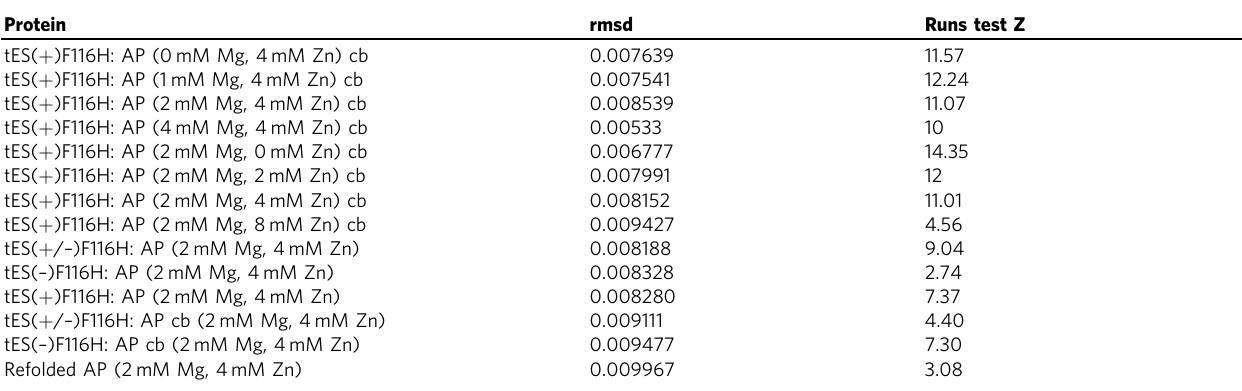
Determining the quality of fi t for AUC curve for AP encapsulated, refolded and released from tES( + )F116H under different concentrations of cofactors Zn 2 + and Mg 2 + , tES( + / – )F116H and tES( – )F116H and AP refolded without tES.